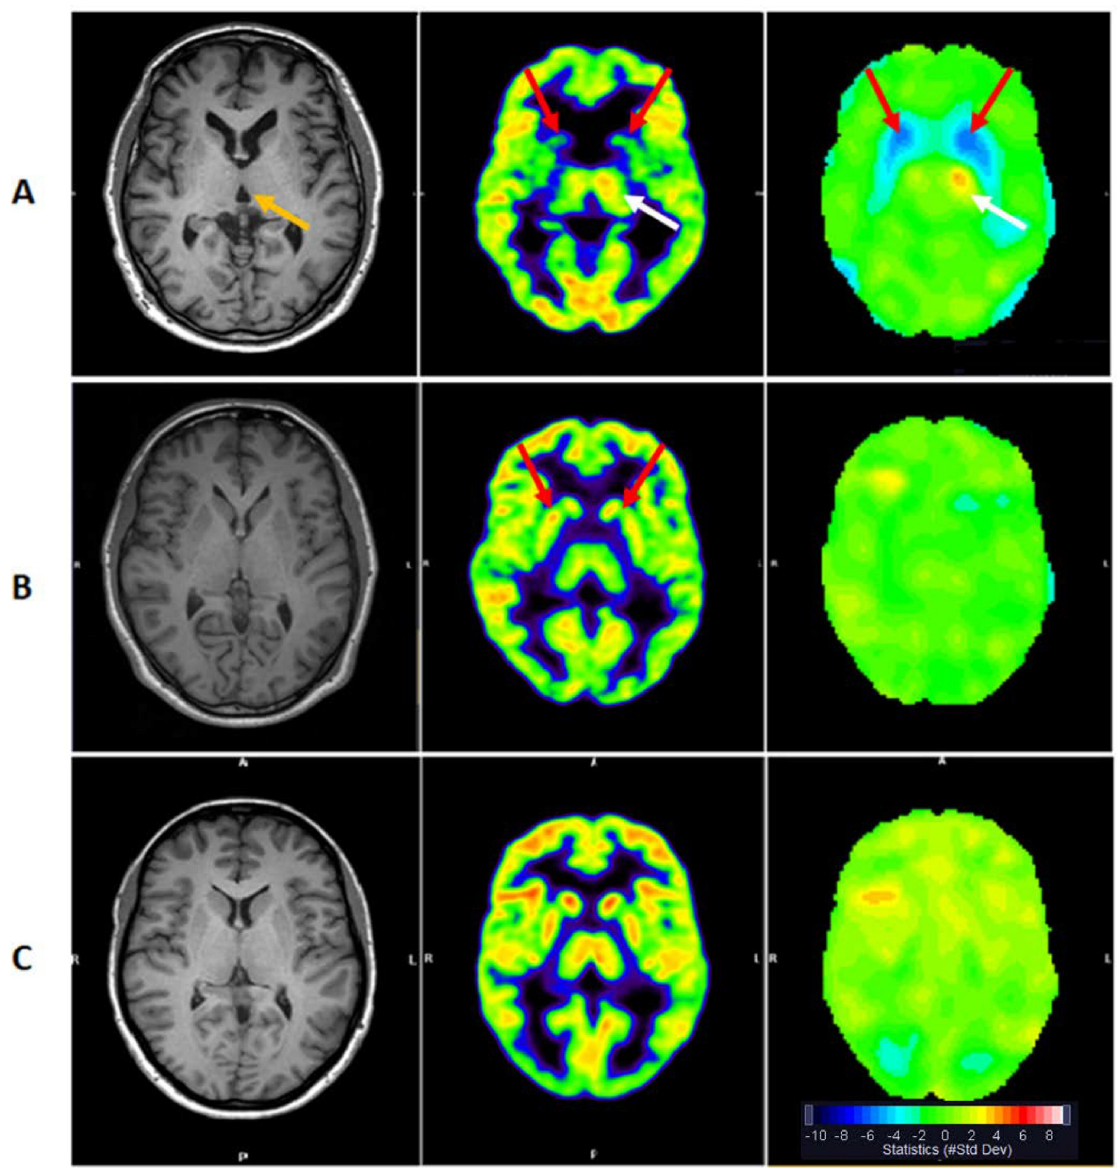
Fig 1. Axial T1 weighted MRI (left), 2-[ 18 F]FDG PET (center) and statistical analysis (right) at the same level in standard anatomical space in two HD gene-expansion carriers (A, B), and a healthy control for comparison (C). Both patients and control had normal MRI. Patient A. 2-[ 18 F]FDG PET SUVR is moderately abnormal with symmetrically decreased metabolism in the Striata (red arrows). Possibly compensatory increased metabolism in the left thalamus (white arrow). CAP S score 1,04. Patient B. 2-[ 18 F]FDG PET SUVR show possibly abnormal metabolism with the impression of slight striatal metabolic reduction (red arrows) compared to the cortex although within normal range in the statistical map. CAP S score 0.91. The figure shows the range of abnormal 2-[ 18 F]FDG PET uptake in patients with high CAP S scores. Note the enlargement of the third ventricle in patient A (orange arrow), that appear as a spurious SPM correlation ( Table 5 ). The statistical maps (right) compare regional activity without PVC normalized to cerebellar activity to a group of age matched controls using (MI Neurology, Siemens) displayed in Z-scores with color scale